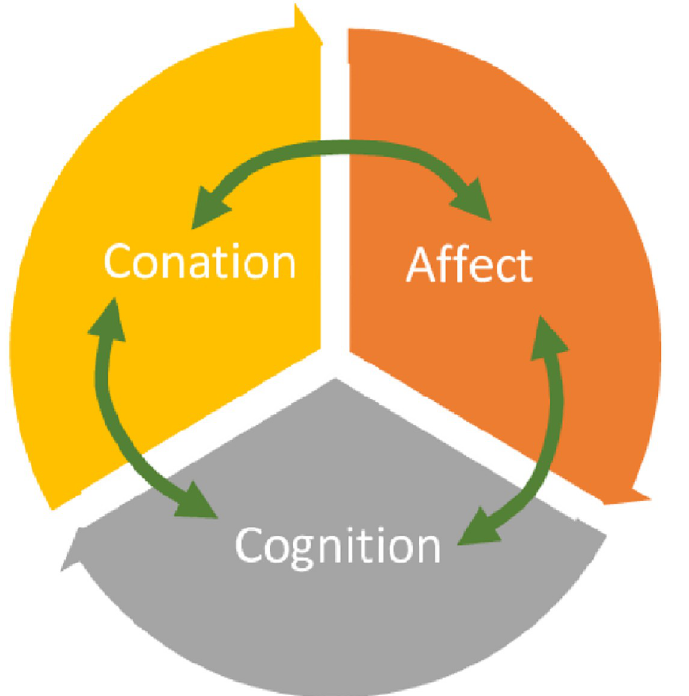
Fig 3. Tri-component attitude model. (Source: